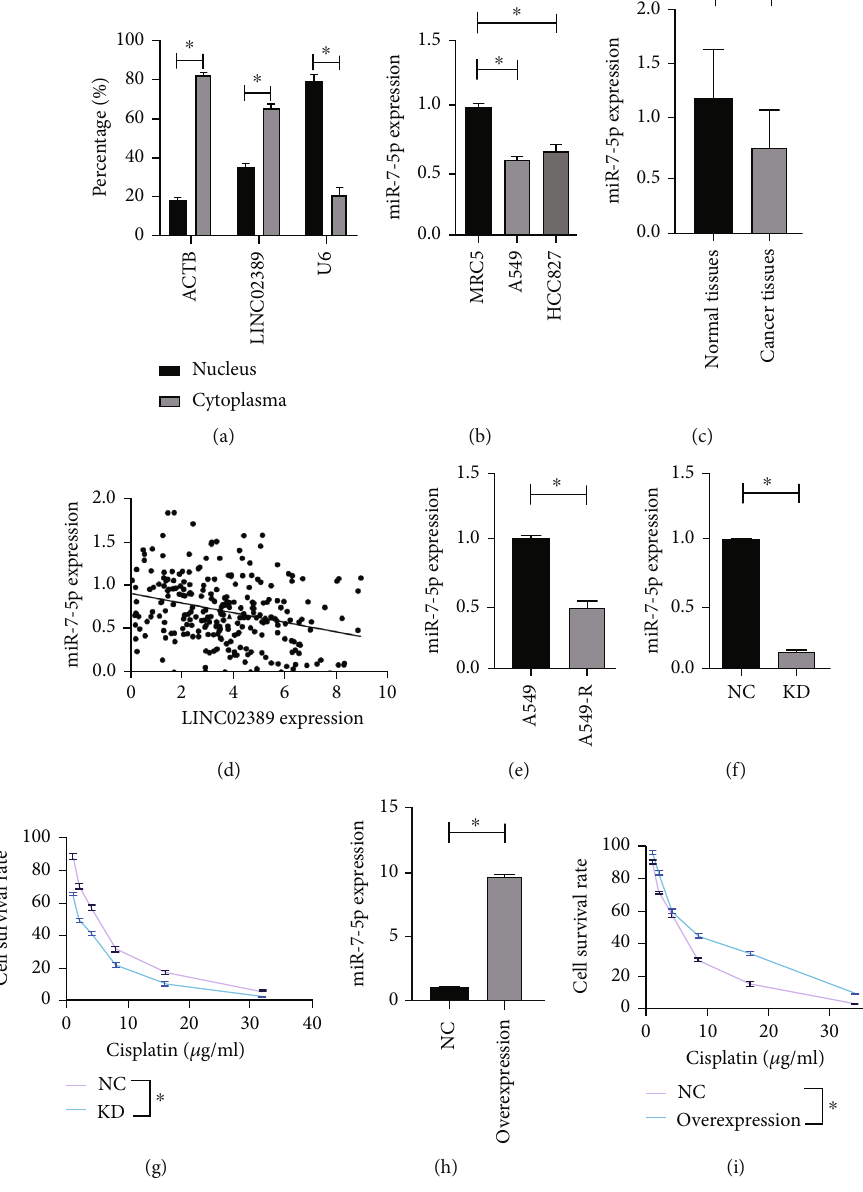
Figure 4: (a) LINC02389 expression in the nucleus and cytoplasma in A549-R. (b) miR-7-5p expression in A549 and HCC827 compared with MRC5. (c) miR-7-5p expression in recurrent and nonrecurrent non-small-cell lung cancer patients. (d) The correlation between miR- 7-5p and LINC02389 expressions in non-small-cell lung cancer patients. (e) miR-7-5p expression in A549-R compared with A549. (f) Knockdown of miR-7-5p in A549-R. (g) CCK-8 assay to evaluate the e ff ect of miR-7-5p knockdown in IC50 of A549-R to cisplatin. (h) Upregulation of miR-7-5p in A549-R. (i) CCK-8 assay to evaluate the e ff ect of miR-7-5p upregulation in IC50 of A549-R to